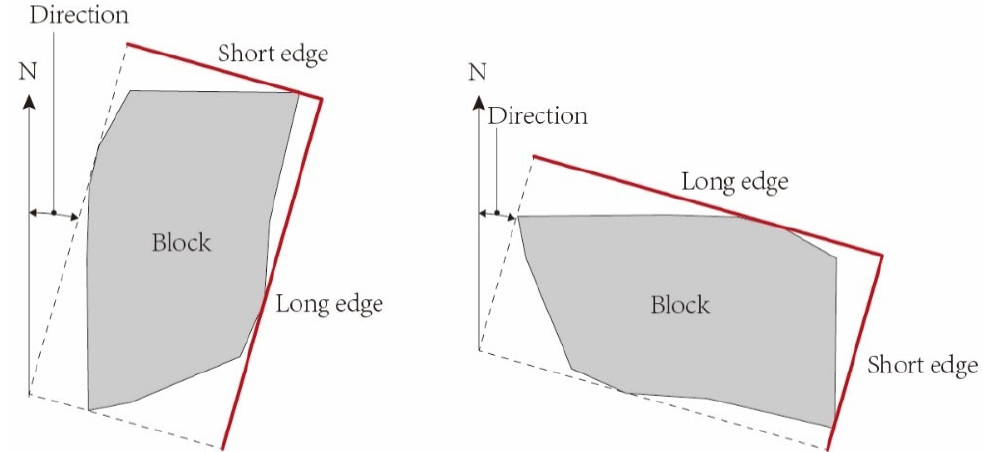
Figure 6. Calculation of long and short edges and minimum boundary geometry for a block area.